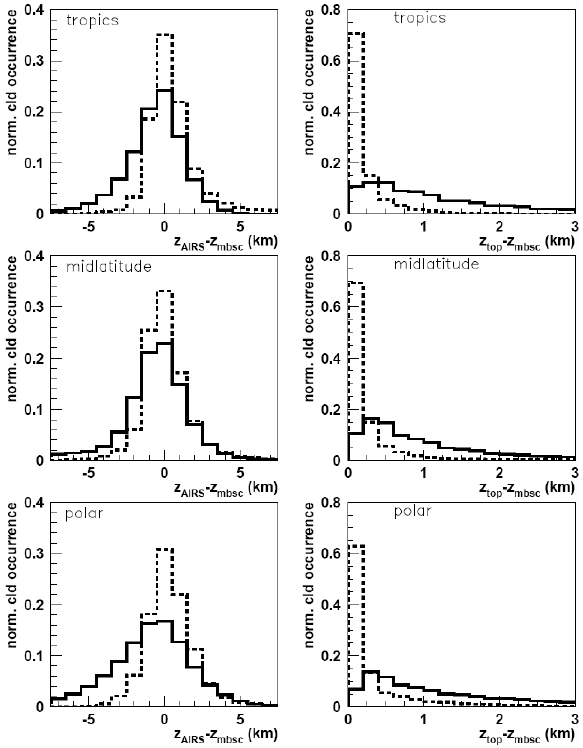
Figure 5. Normalized frequency distributions of the difference between the cloud height of AIRS-LMD and the height of maximum backscatter of the uppermost cloud layer detected by CALIPSO, excluding subvisible cirrus, (left) and the difference between cloud top and height of maximum backscatter (right), separately for high clouds (full line) and midlevel/low clouds (broken line) as determined by CALIPSO, for the latitude bands 30°N-30°S (upper panels), 30°-60° (middle panels) and 60°-90° (lower panels).